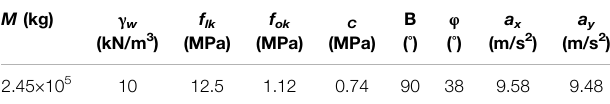
TABLE 1 | Model calculation parameters.